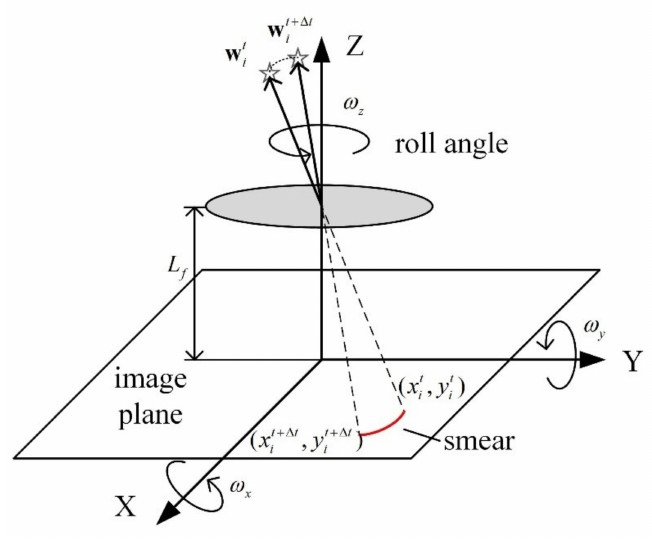
Figure 2. Schematic diagram of the coordinate system and smear on the image during rotation.